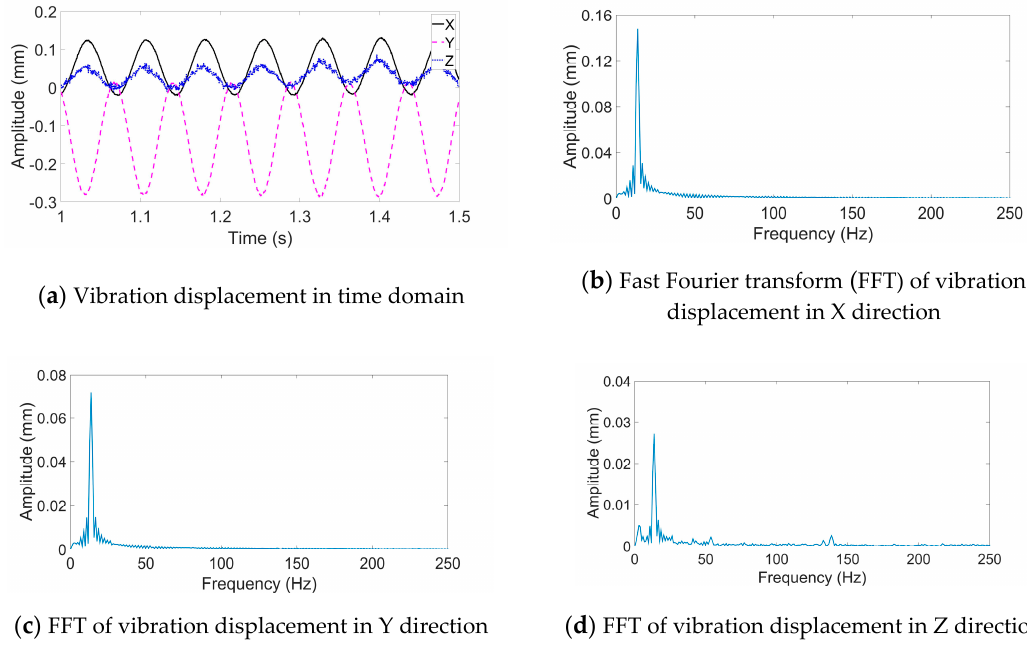
Figure 7. Vibration displacement in time and frequency domain under 14 Hz excitation frequency.